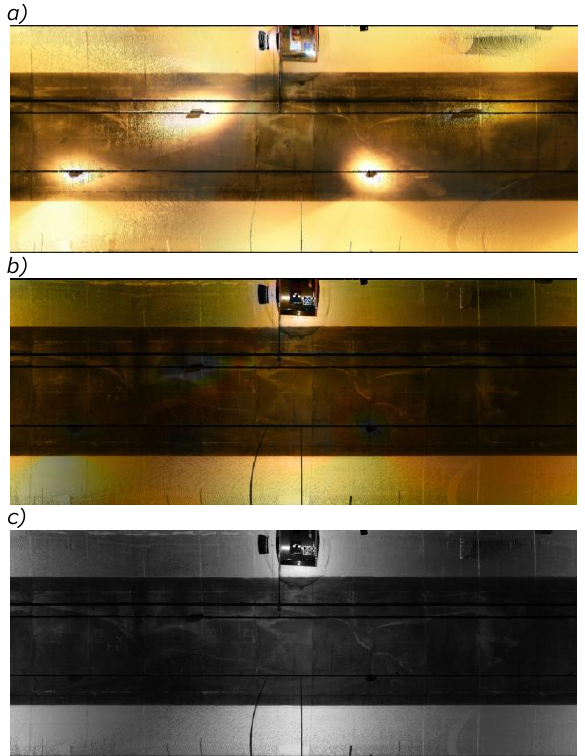
Figure 12. Scan of the ceiling of a tunnel in cylindrical projec- tion. The RGB image (in a ) is overexposed around the light projectors, while the laser intensity (in c ) is perfectly readable. In the b image the RGB lightness is tuned according to the la- ser intensity.